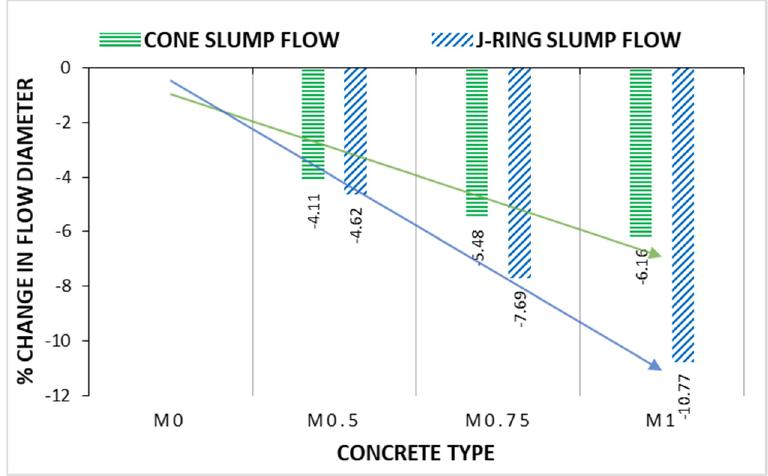
Figure 8. Percentage changes in flow values for different SCC types.